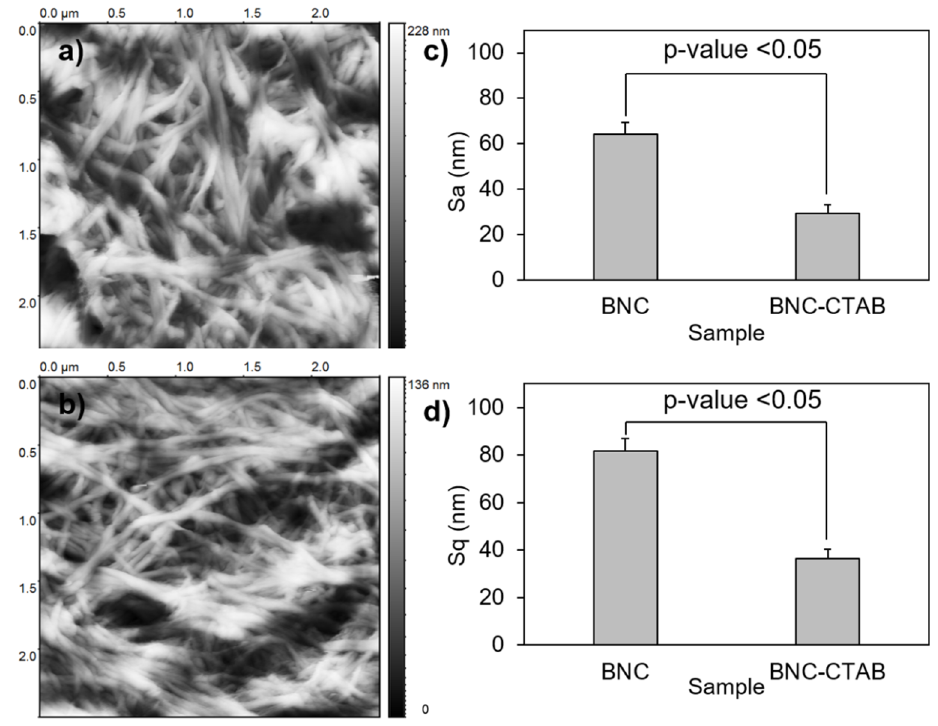
Figure 8. Roughness analysis; ( a ) AFM micrographs of BNC; ( b ) AFM micrographs of BNC-CTAB; ( c ) average of Sa; ( d ) average of Sq. The sample groups were statistically different with p values < 0.05.